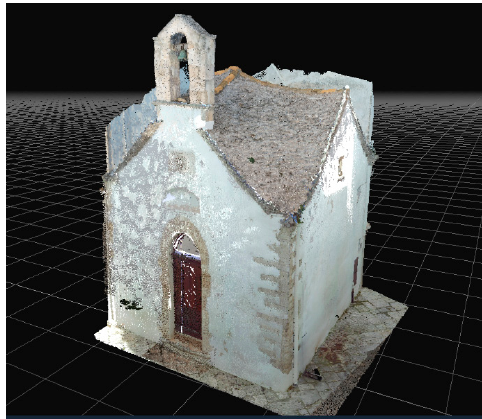
Figure 7. Three-dimensional (3D) point cloud of San Nicola in Montedoro.